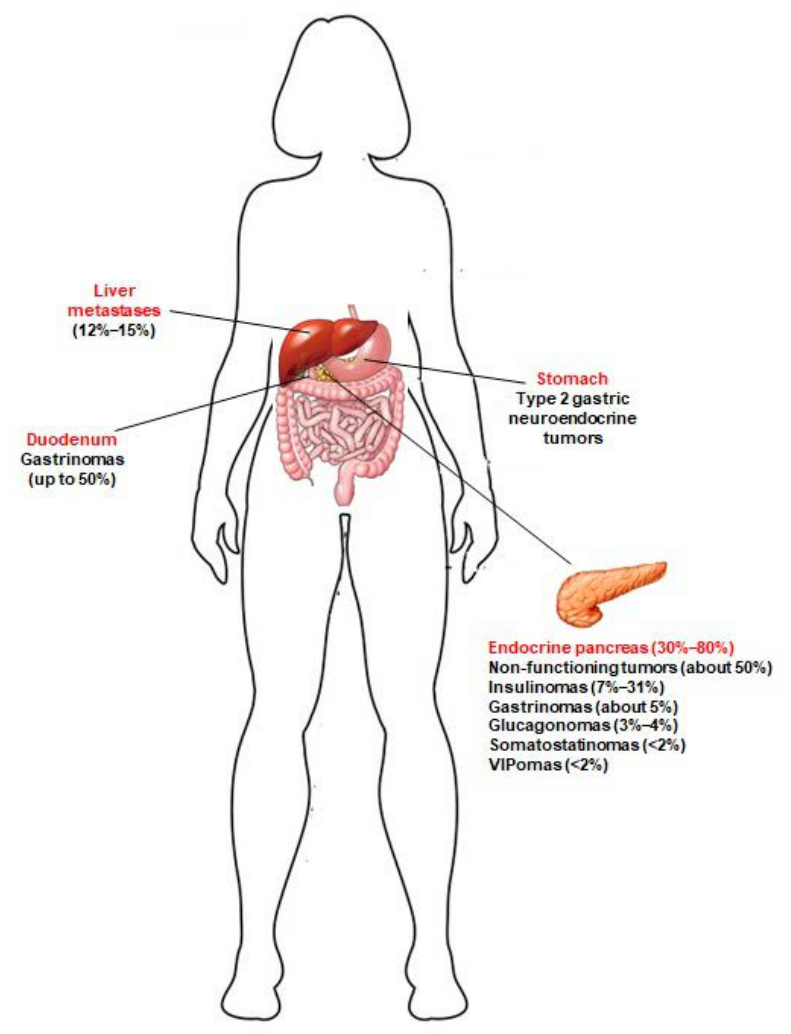
Figure 1. Neuroendocrine tumors of the gastro-entero-pancreatic tract associated with MEN1 syn- drome. Prevalence of these tumors in MEN1 patients is indicated between brackets. Type 2 gastric neuroendocrine tumors develop in MEN1 patients, as a consequence of Zollinster–Ellison syndrome (ZES) from duodenal and/or pancreatic gastrinomas; to date, little is known about the true prevalence of these gastric neuroendocrine lesions in MEN1 patients. Jensen et al. [5] indicated a prevalence of 7–35%. Recently, Manoharan et al. [8] demonstrated that type 2 gastric neuroendocrine tumors occur only in MEN1 patients with ZES, and less frequently than previously reported (5.3% of the total of MEN1 patients and 12.5% of MEN1 patients with